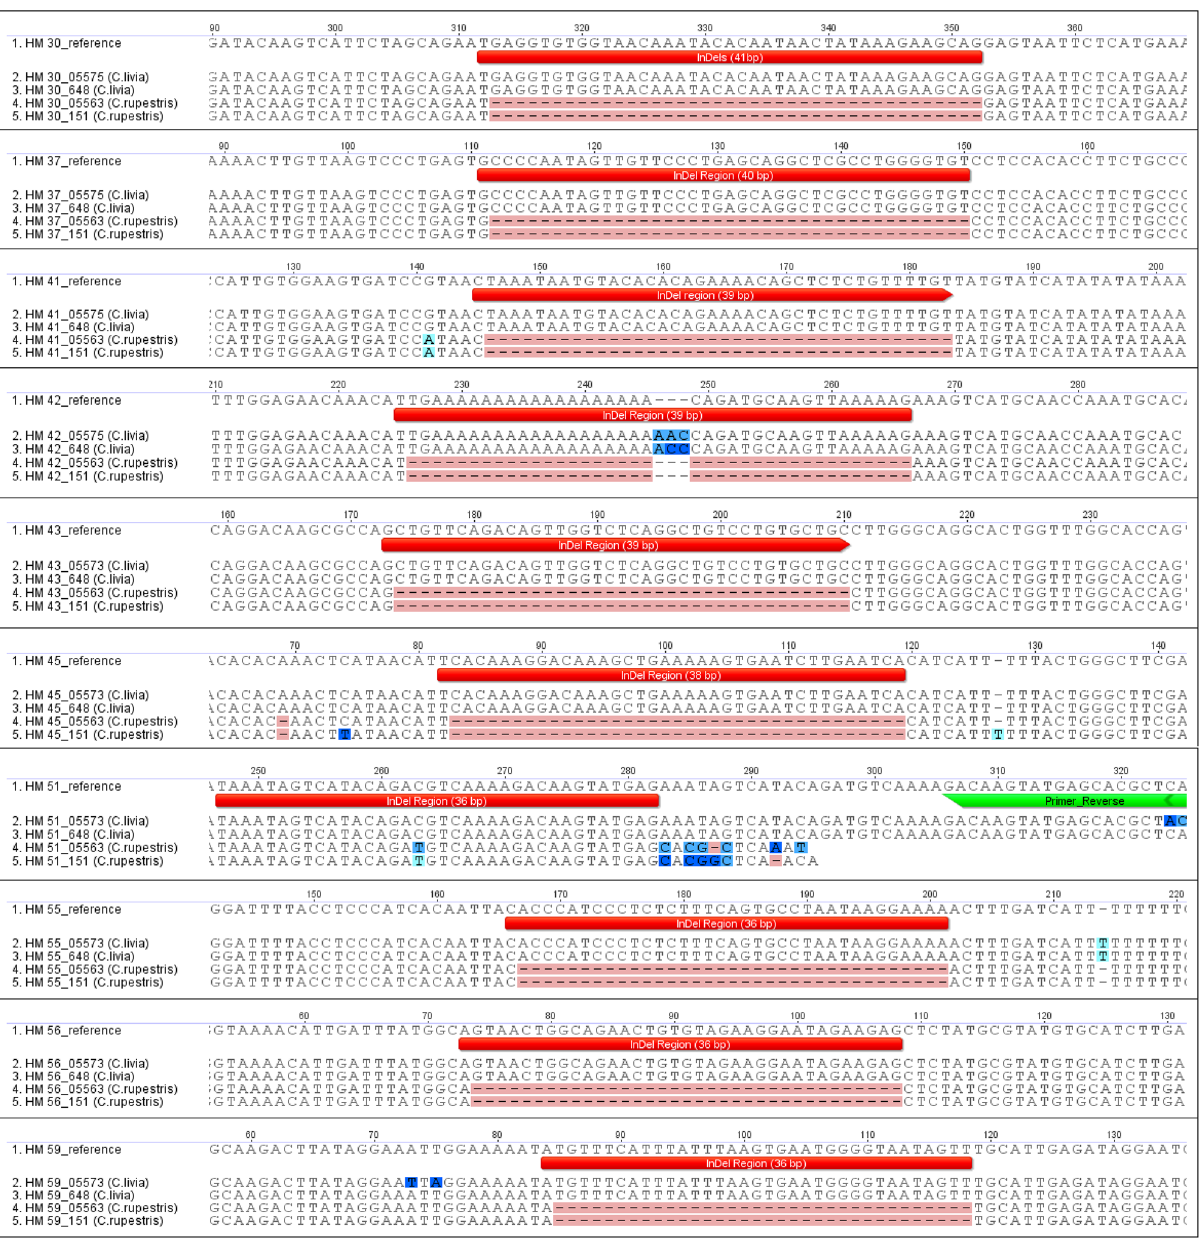
Figure 2. Sequences of 10 selected InDel markers to identify the F1 hybrids between hill and feral pigeons. Data are shown for two randomly selected individuals in the two